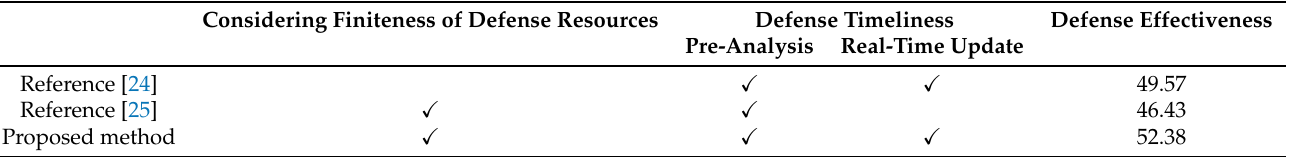
Table 3. Comparison amongst cyber defense approaches in terms of considering the finiteness of defense resources , defense timeliness , and defense effectiveness